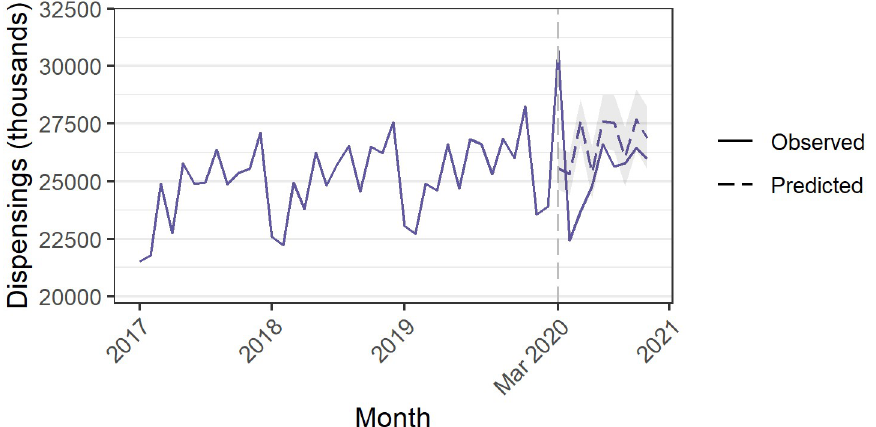
Fig 1. Dispensing of all medicines. Grey shaded area = 95% confidence interval for predicted values.